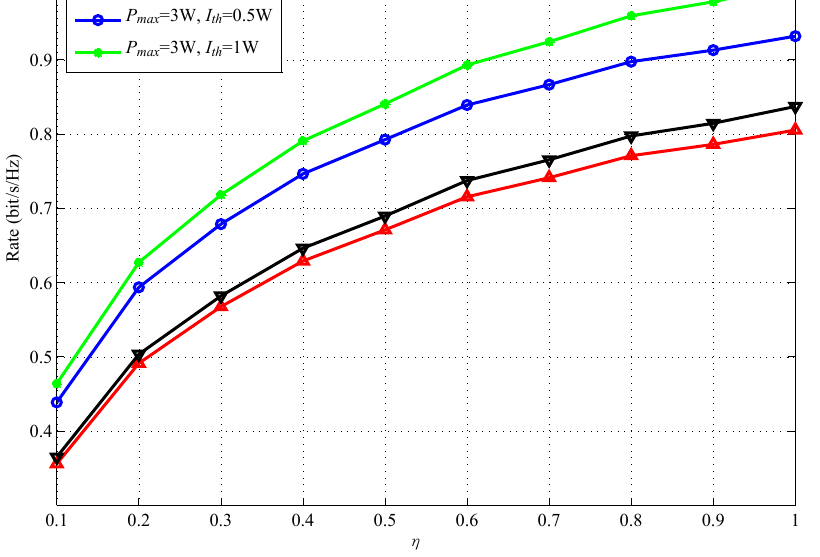
Figure 8. Achievable rate versus η .